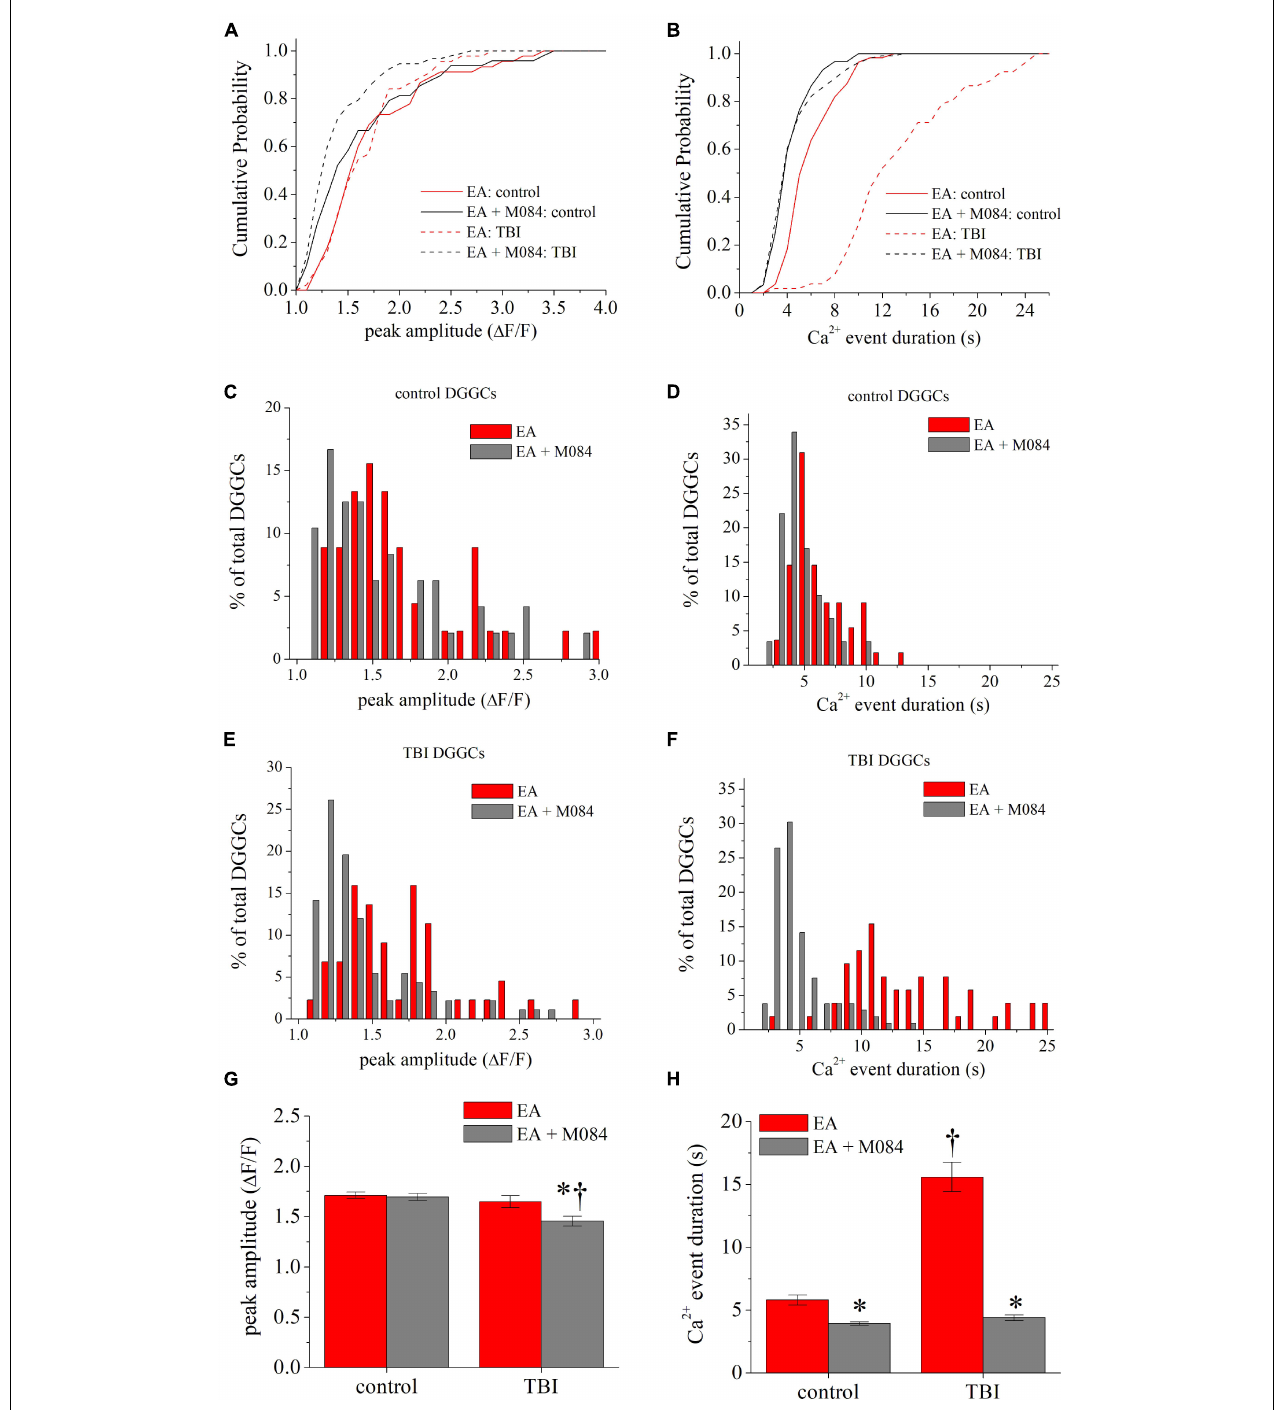
FIGURE 5 | TRPC4/TRPC5 channel activation artificially prolongs Ca 2 + influx in DGGCs after CCI-TBI. (A) Cumulative probability distribution of the peak amplitude of GCaMP6f fluorescence ( (cid:49) F/F) for each DGGC from sham (control) and iTBI slices during EA (1 µ M, red) or EA + M084 (10 µ M, gray) application. (B) Cumulative probability distribution of the Ca 2 + influx duration (in seconds) for each DGGC from control and iTBI slices during EA or EA + M084 application. (C,D) Histogram population distribution of control DGGC Ca 2 + influx events according to peak amplitude (C) and Ca 2 + event duration (D) . (E,F) Histogram population distribution of iTBI DGGC Ca 2 + influx events according to peak amplitude (E) and Ca 2 + event duration (F) . (G) Summarized means of peak fluorescence from data as in Panel (A) . (H) Summarized means of Ca 2 + influx duration from data as in Panel (B) . Red = EA alone, gray = EA + M084. All data bars represent the mean ± SEM. * p < 0.05 vs. EA alone from same procedure condition, † p < 0.05 vs. control of same drug